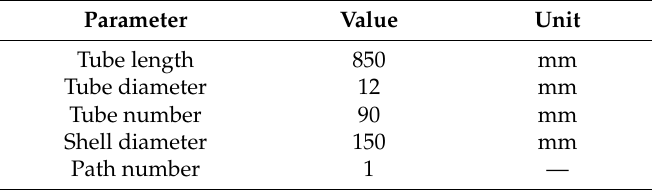
Table 2. The main parameters of the